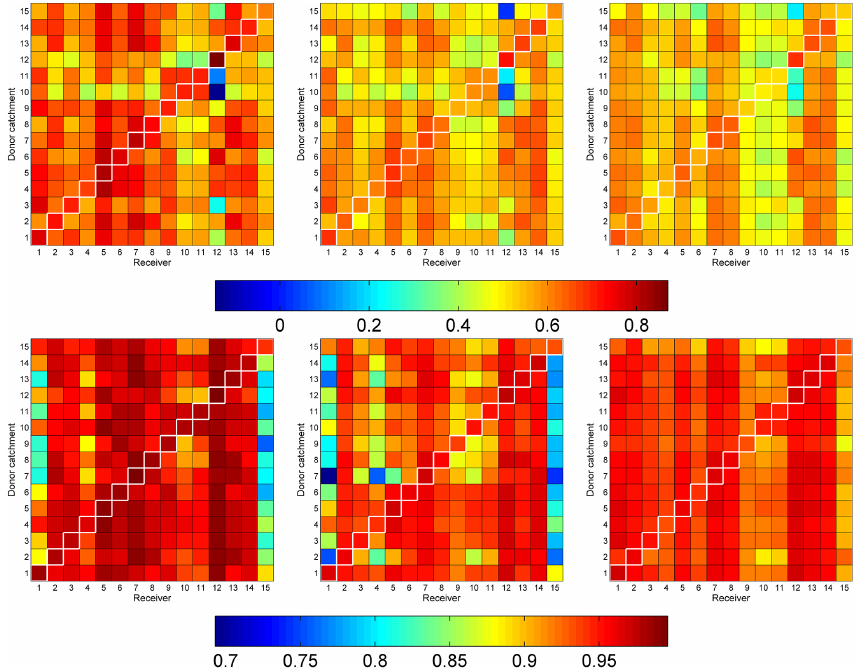
Figure 3. Color-coded matrices for the mean model performance of the parameter transfer for the selected 15 catchments. The upper panel used NS as performance measure, the lower panel used GK as performance